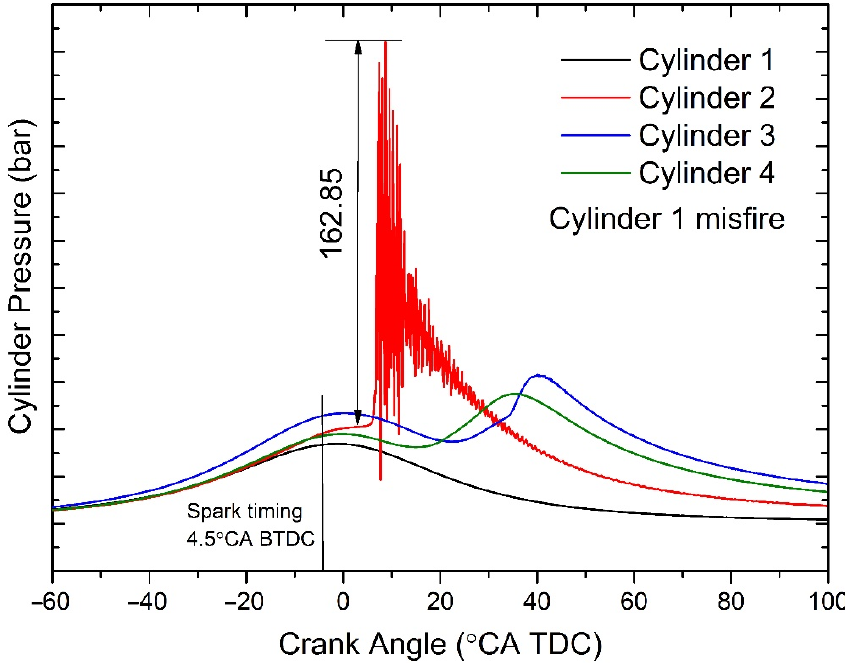
Energies 2021 , 14 , x FOR PEER REVIEW Figure 10. Super ‐ knock in the last ignition cylinder corresponding to the misfired cylinder. Figure 10. Super-knock in the last ignition cylinder corresponding to the misfired cylinder.